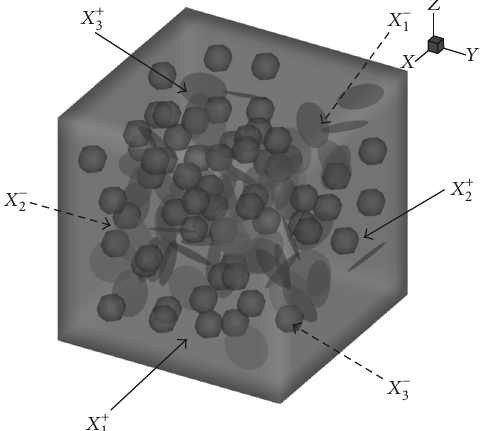
Figure3:Anisotropiccubecontainingrandomlylocatedspheroidal microvoids and circular